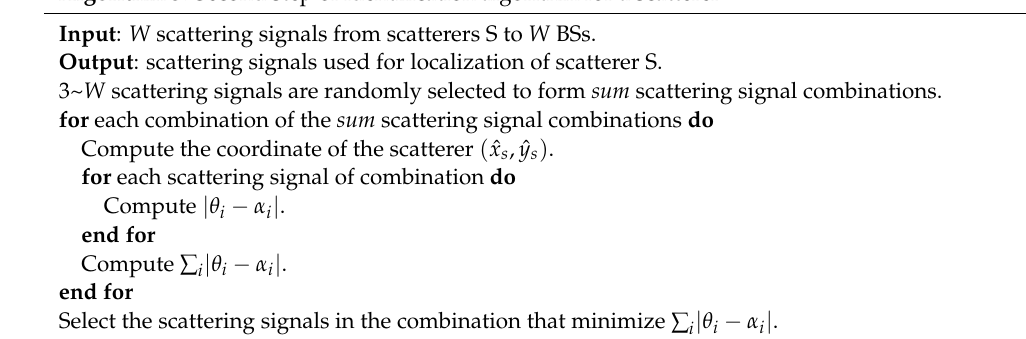
Algorithm 3 : Second step of identification algorithm for a